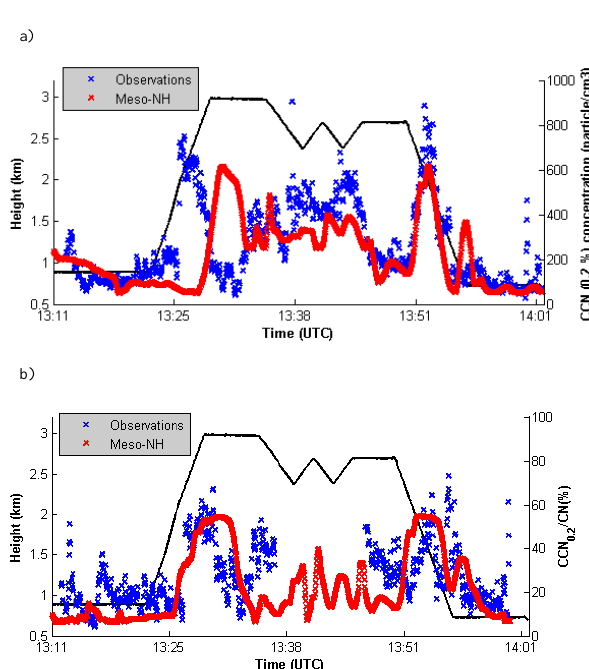
Figure 11. Evolution of (a) the CCN concentration and (b) the N CCN / N CN ratio at 0.2% supersaturation obtained from CCNC and CN concentration (blue line) and calculated from the simula- tion (red line) over the Netherlands between (52.57 ◦ N, 6.34 ◦ E) and (51.88 ◦ N, 4.99 ◦ E) on 30 May 2008. The black line indicates the height of the aircraft.